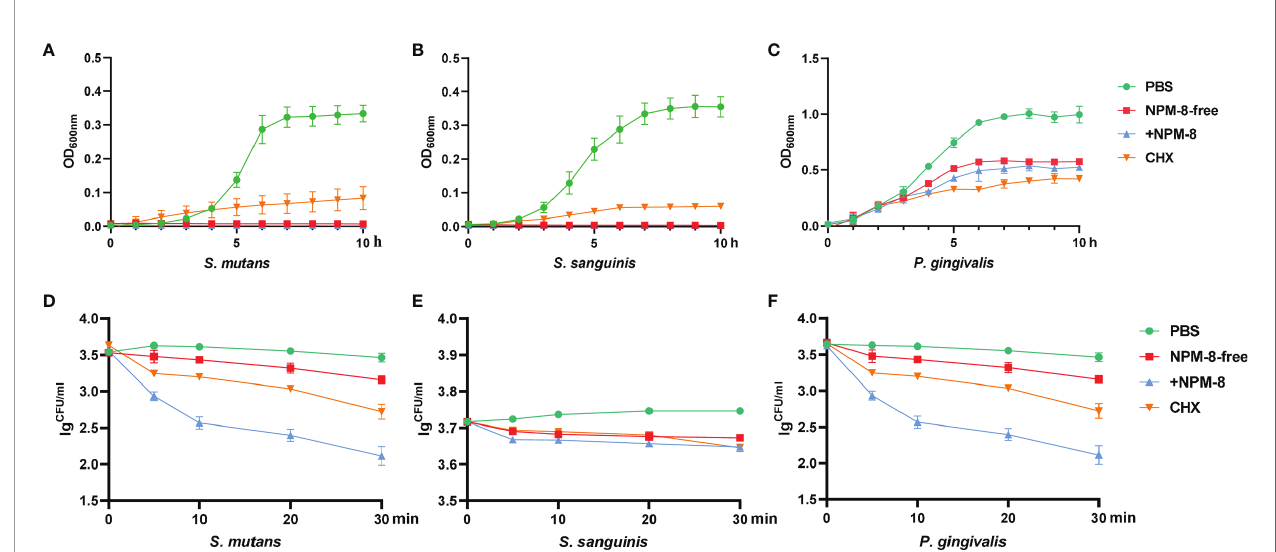
FIGURE 1 | Antibacterial activity of the four test agents on S. mutans , S. sanguinis and P. gingivalis . (A) Growth curves of S. mutans in PBS, NPM-8-free toothpaste, NPM-8-containing toothpaste and CHX treatment. (B) Growth curves of S. sanguinis under the four test agent treatments. (C) P. gingivalis growth curves. (D) Time-kill curves for S. mutans under the four test agent treatments. (E) S. sanguinis time-kill curves. (F) P. gingivalis time-kill curves. Data are represented as means ±